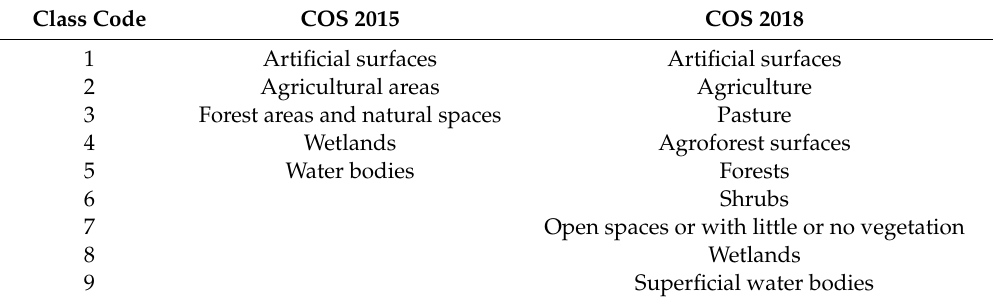
Table 3. Classes of level 1 nomenclature of COS 2015 and COS